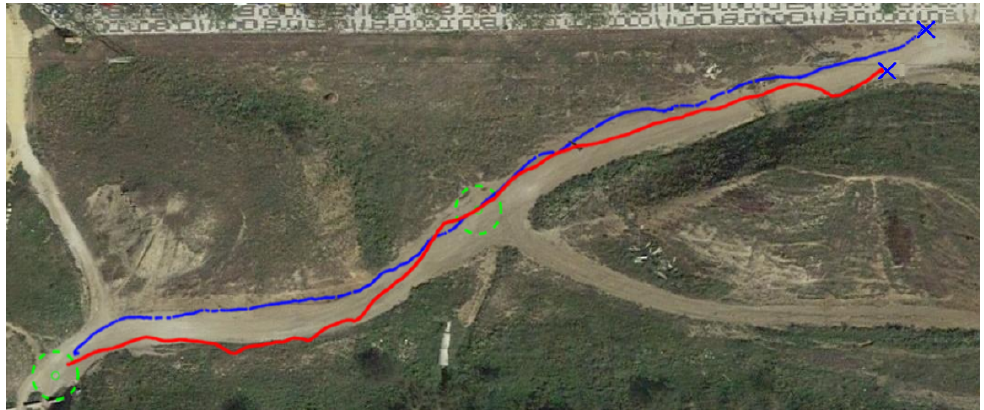
Figure 22. Comparison between reactive and RL paths on the hollow, represented with blue and red lines, respectively.